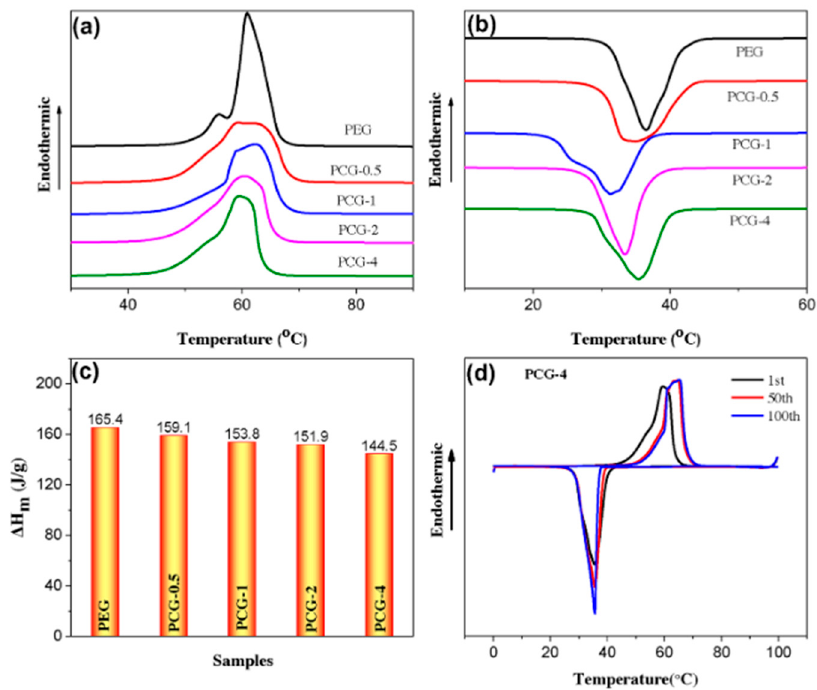
Figure 14. ( a ) Heating DSC; ( b ) cooling DSC; ( c ) melting LH; and ( d ) cyclic analysis [100].